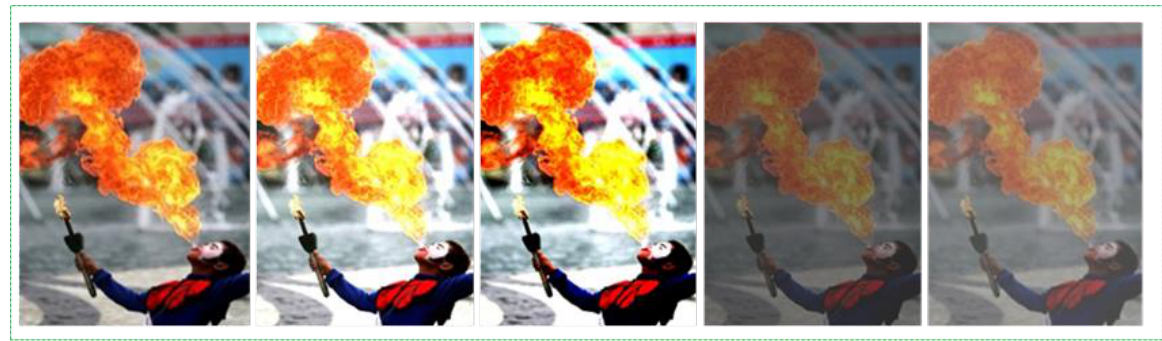
Figure 7. Fire images before and after hue augmentation.